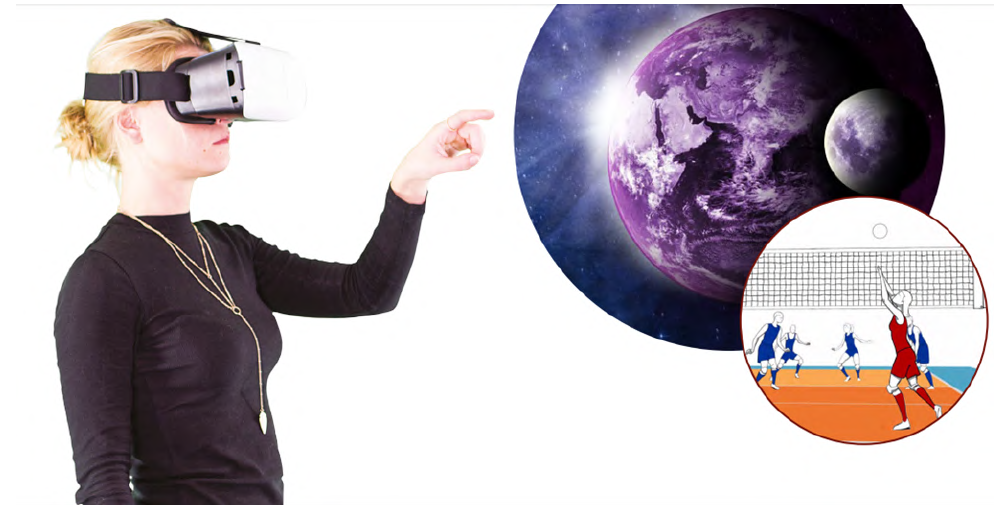
Figure 2: Organization of individual training using SGM SPORTS